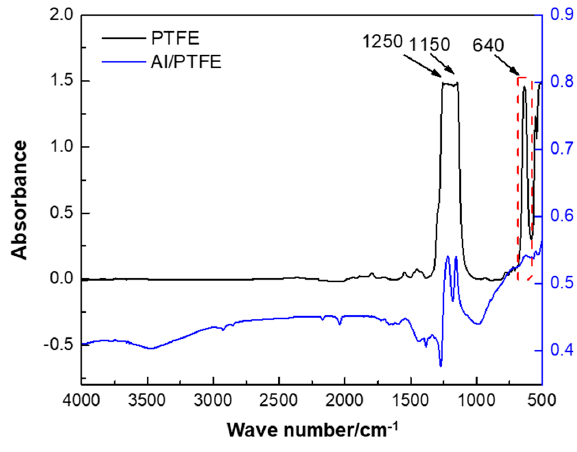
Figure 2. Fourier transform infrared spectroscopy (FTIR) spectra of PTFE coated Al. The PTFE was pressed into a transparent sheet. The Al/PTFE sample was mixed with potassium bromide (KBr) and pressed.